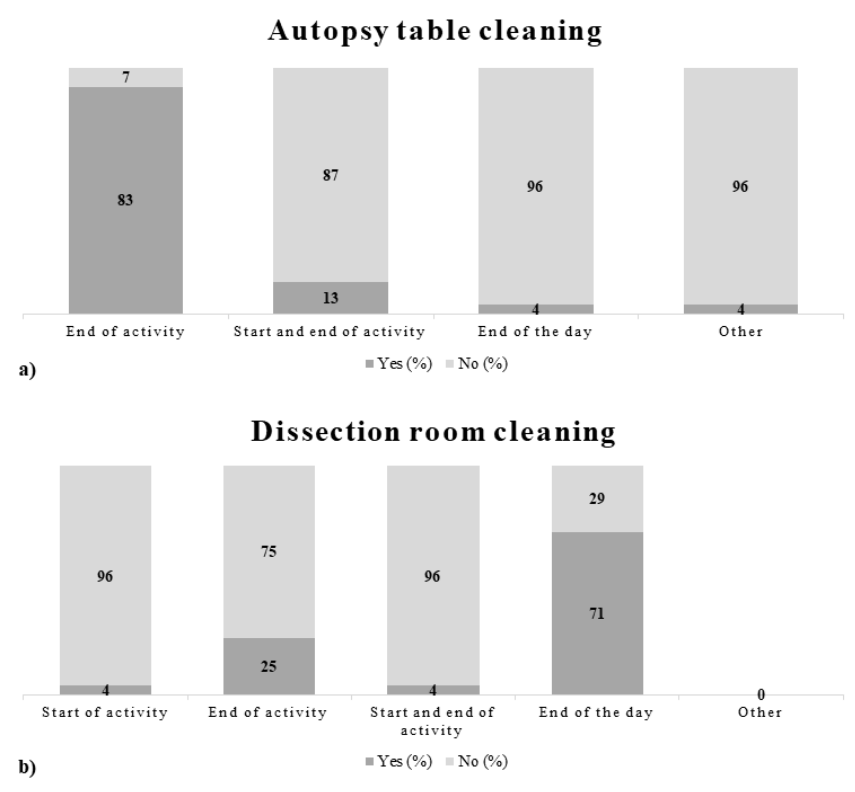
Figure 4. Data on cleaning procedures.